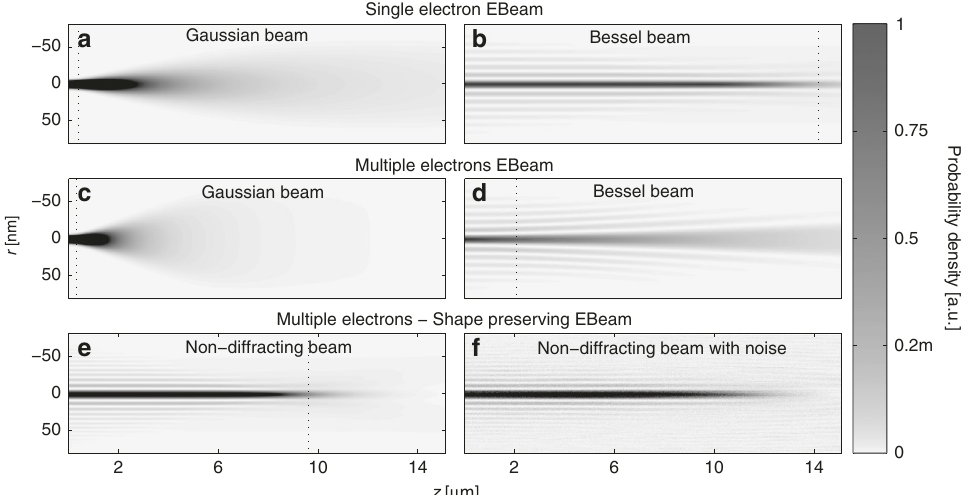
Fig. 3 Evolution of the density of various single- and multi- electron beams. a , b Propagation of a single-electron beam (which does not have self-repulsion) with initial Gaussian and Bessel wavefunctions, respectively. c , d Propagation of the respective cases for EBeams containing multiple electrons. The repulsion among the electrons makes the Gaussian EBeam diffracts faster than in a , while the Bessel broadens considerably and is no longer shape preserving. e Propagation of the non-diffracting multi-electron beams with the wavefunction of Fig. 1a. The beam preserves its shape for a large distance in spite of the repulsion among electrons. f Same as e with added noise, exhibiting robustness to high level of noise (uniformly distributed Gaussian noise that carries the same power as the beam). The dashed lines in a – e , indicate the range of non-diffraction of each beam. Here, the EBeams are accelerated by voltage of 200 V, having beam current of I = 5 μ A (for the multi-electron beams), and effective width of 16 nm (Eq.